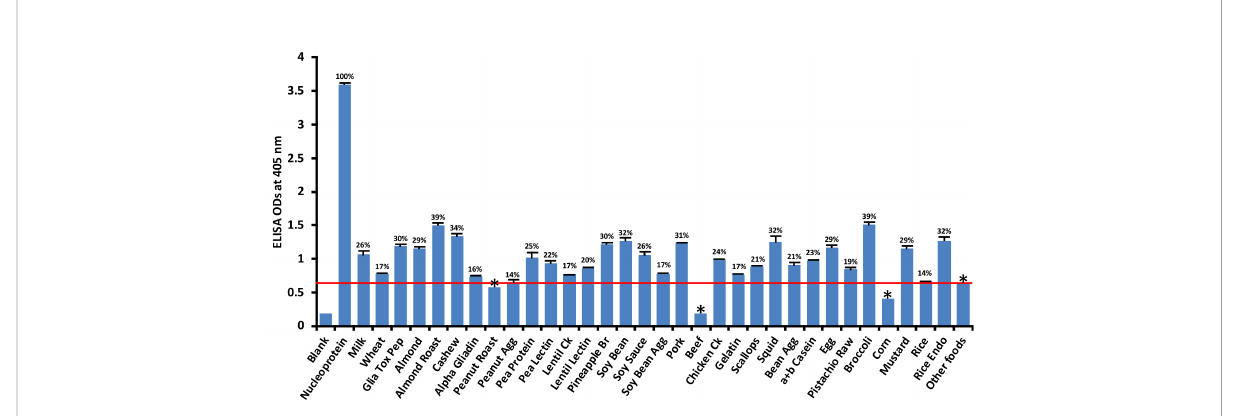
FIGURE 4 Reaction of human SARS-CoV-2 nucleoprotein monoclonal antibody with various food antigens. At 3SD above the OD of antibody reaction with non-reactive foods or OD of 0.64, the nucleoprotein antibody reacted signi fi cantly with 26 out of 180 tested food proteins and peptides. The data was obtained from quadruplicate testing. The SDs for all the reactions were less than 0.1, and are shown as error bars. * = Antigens whose reactions were under the cutoff and/or close to the blank. Glia Tox Pep, Gliadin Toxic Peptide; Peanut Agg, Peanut Agglutinin; Soy Bean